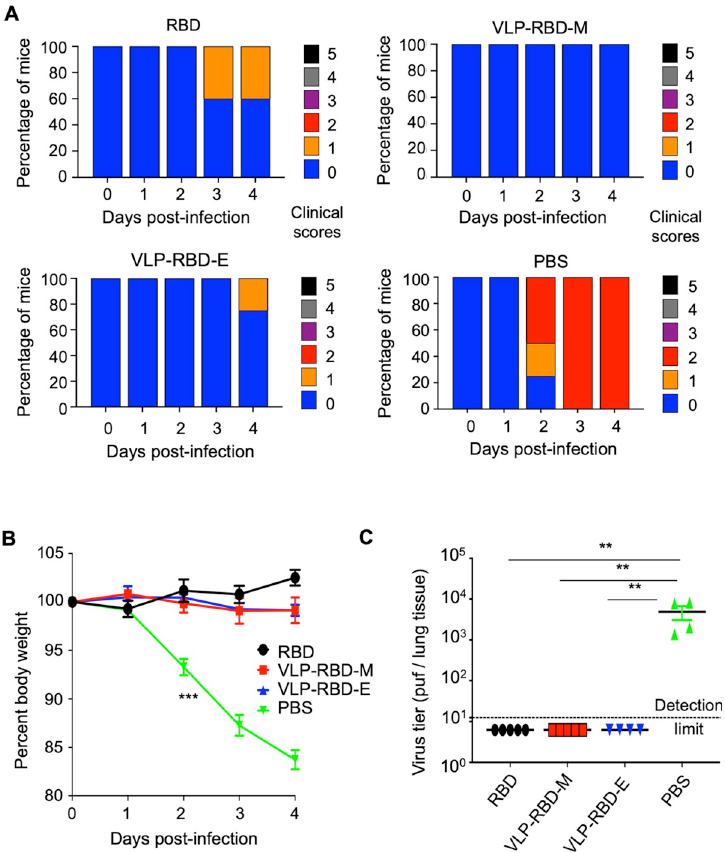
Fig 5. VLP-RBD vaccine protects mice from SARS-CoV-2 infection in vivo . Mice were immunized with VLP-RBD vaccine, RBD vaccine or PBS, and were then intranasally challenged with a mouse-adapted SARS-CoV-2 strain. Clinical scores (A), body weights (B), and virus titers in the lung tissue (C) of mice were recorded. The data are presented as mean ± SEM (n = 4–5 for mice in each group). For (B), a two-way ANOVA with a Dunnett’s multiple comparisons post-test was performed to analyze the statistical differences among the groups. For (C), a Kruskal-Wallis test with Dunn’s multiple comparisons was performed to analyze the statistical differences among the groups. ��� p < 0.001; �� p <